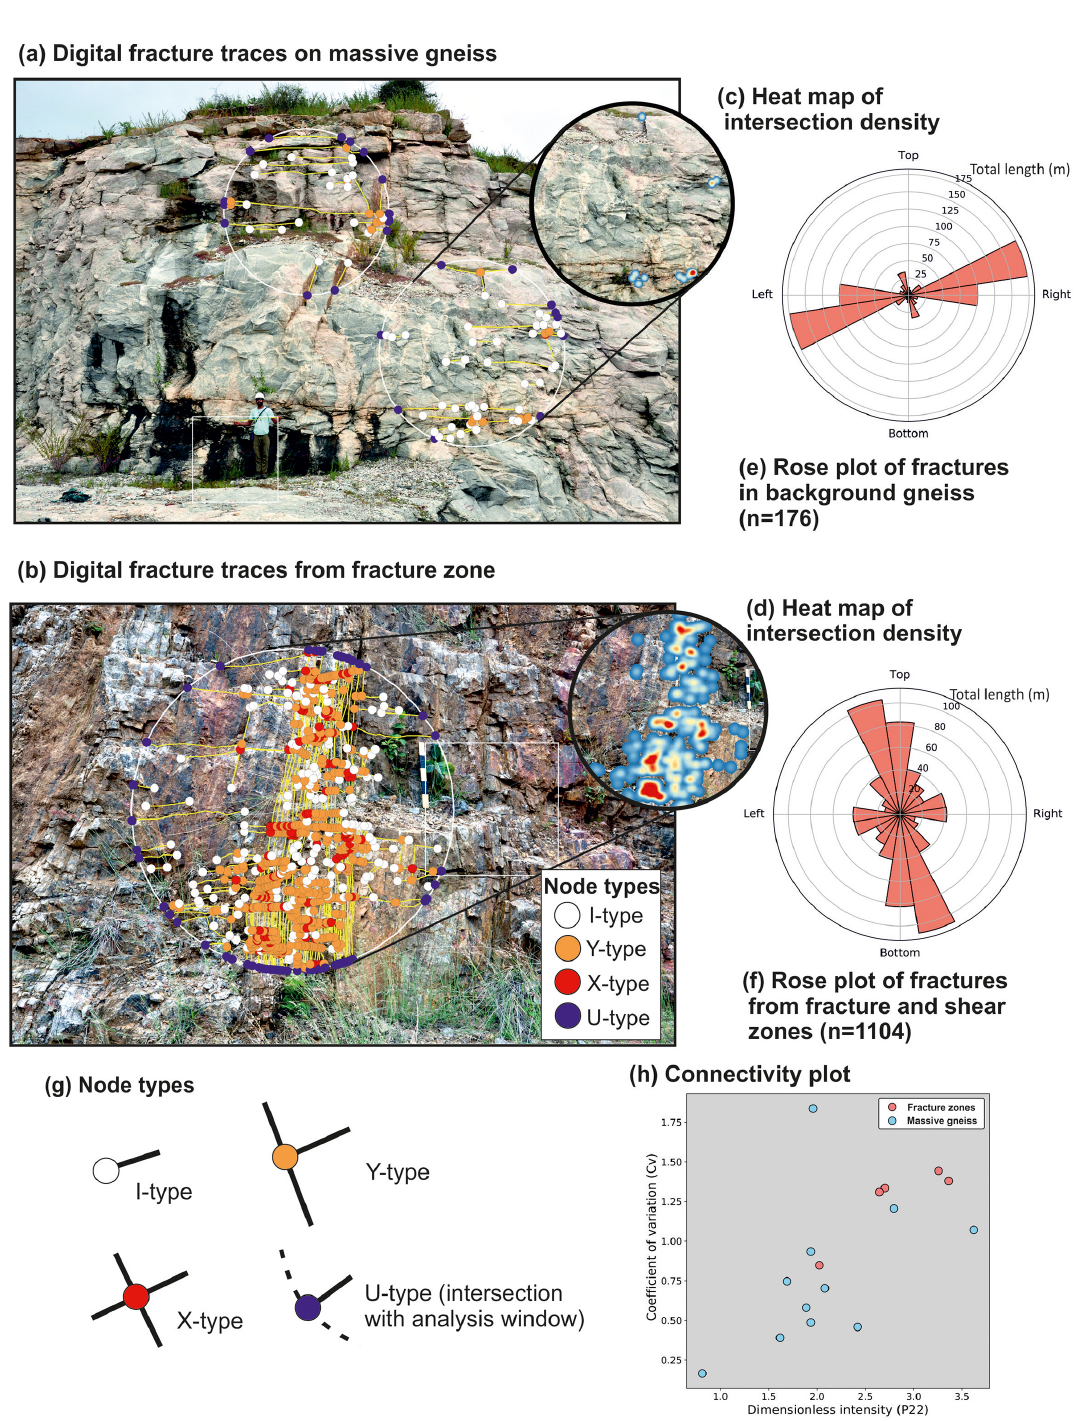
Figure 4. Fracture analysis from the Peninsular Gneiss, southern India, including field photographs with digitized fracture branches and intersection types on (a) a massive gneiss example and (b) from a fracture zone; (c–d) heat maps illustrate variations in fracture intersection density (massive gneiss: 0–5nodesm − 2 ; fracture zones: 0–18nodesm − 2 ); (e–f) length-weighted rose plots showing the variation in orien- tation of fracture traces in the background gneiss and fracture zones; (g) a schematic illustration of the various types of fracture connections (as defined by Manzocchi, 2002); (h) a plot of connections per line against dimensionless intensity (defined by Sanderson and Nixon, 2015) to show variations in